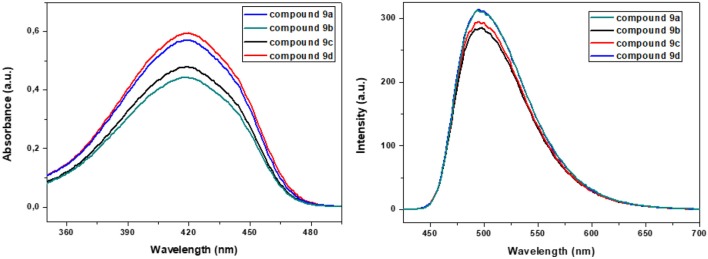
Absorbance (left) and emission (right) spectra for compounds 9a–d in CHCl3 solution (10−5 mol L−1).